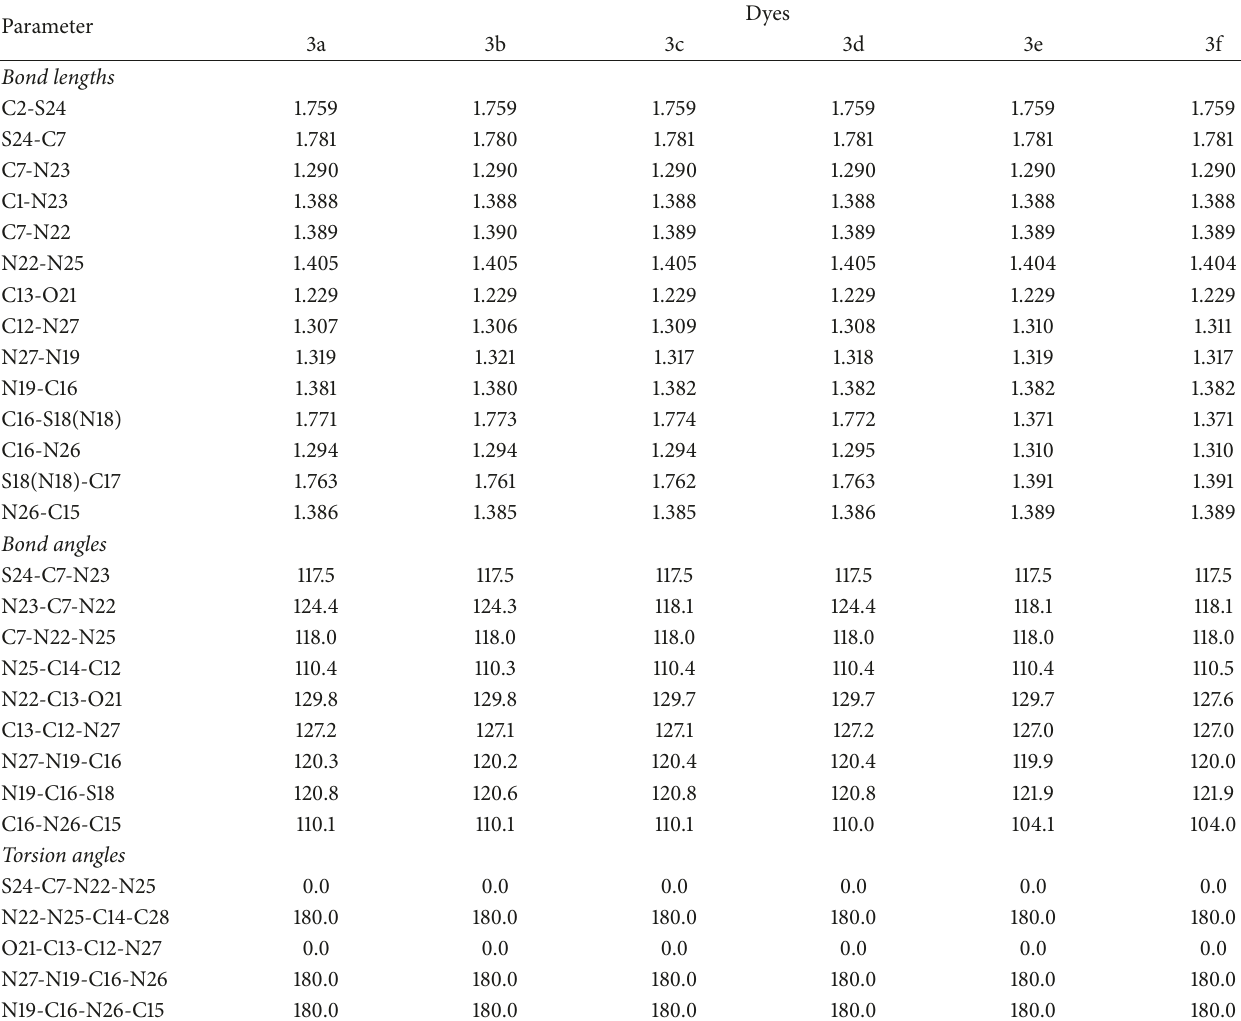
Table 4: Calculated structural parameters (bond lengths in ˚A, angles in degree) of the dyes 3a–3f.